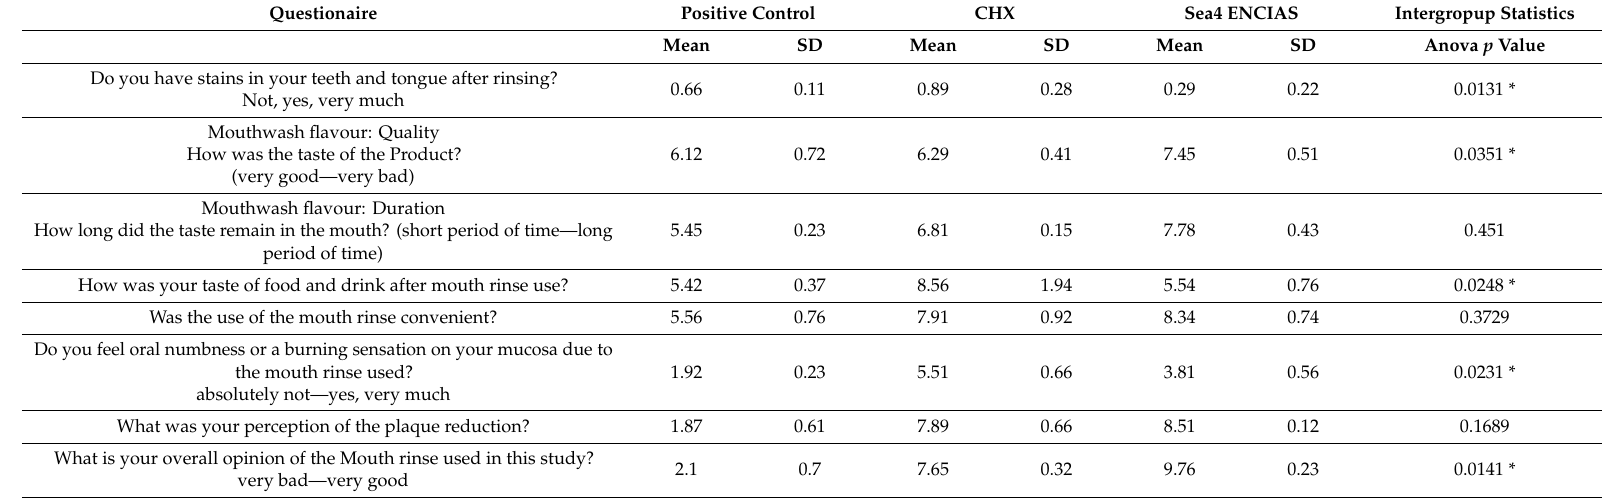
Table 1. Patients’ perception of the product—VAS. n.s., no statistically significant di ff erence between each treatment, p > 0.0125. * Using Friedman test, p < 0.05. * Using Wilcoxon signed-rank test with Bonferroni adjustment for multiple comparison, p <